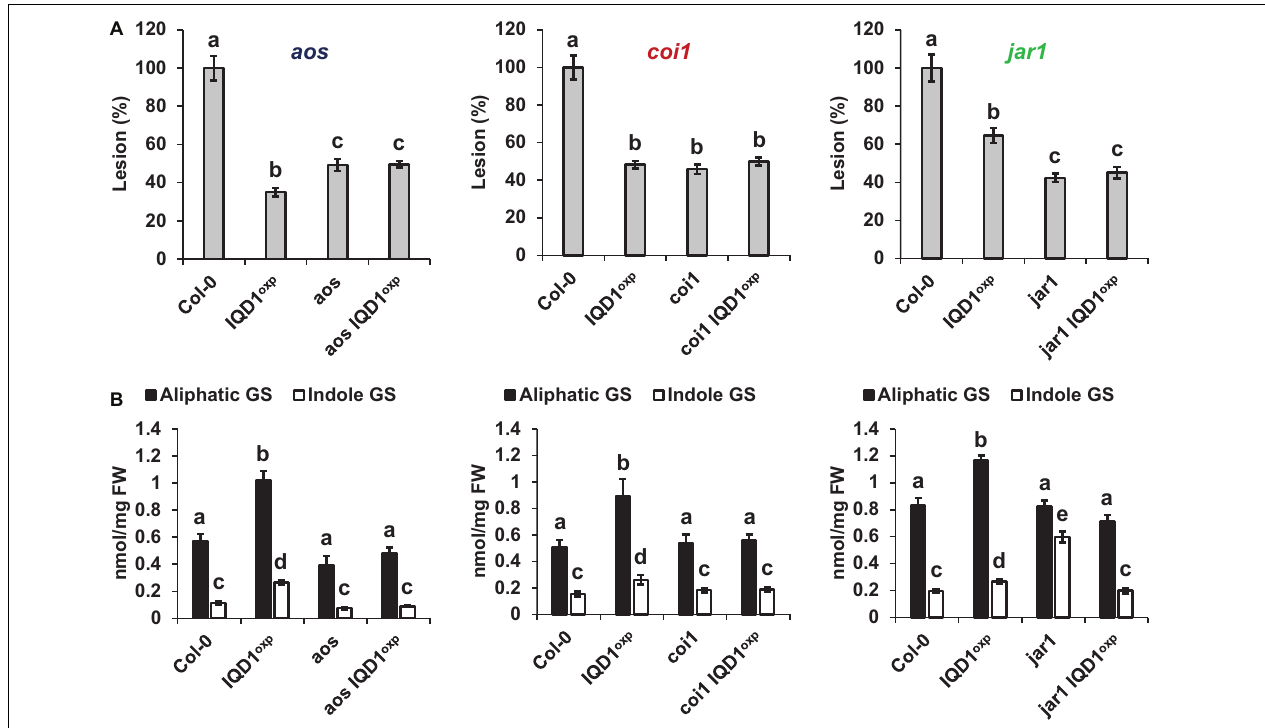
FIGURE 5 | IQD1 OXP affects JA pathway mutants. (A) Detached leaves from 6 week-old Arabidopsis JA pathway mutants were inoculated with B. cinerea . Lesion sizes were measured 72 h post-inoculation. Average lesion sizes from 30 leaves of each line are presented along with the standard error of each average. All numbers are presented as the relative percentage to their corresponding background wild-type. Different letters above the columns indicate statistically significant differences at P < 0.05, as determined using Tukey’s honest significant difference test. (B) Glucosinolates were extracted from seedlings of 6 week-old Arabidopsis SA pathway mutants and analyzed by HPLC. Mean contents of methionine-derived (black bars) and tryptophan-derived (gray bars) glucosinolates are given for each line. Each column represents an average of eight seedlings, with standard error bars indicated. Different letters above the columns indicate statistically significant differences at P < 0.05, as determined using Tukey’s honest significant difference test. Results shown are from a biological replicate, representative of three independent